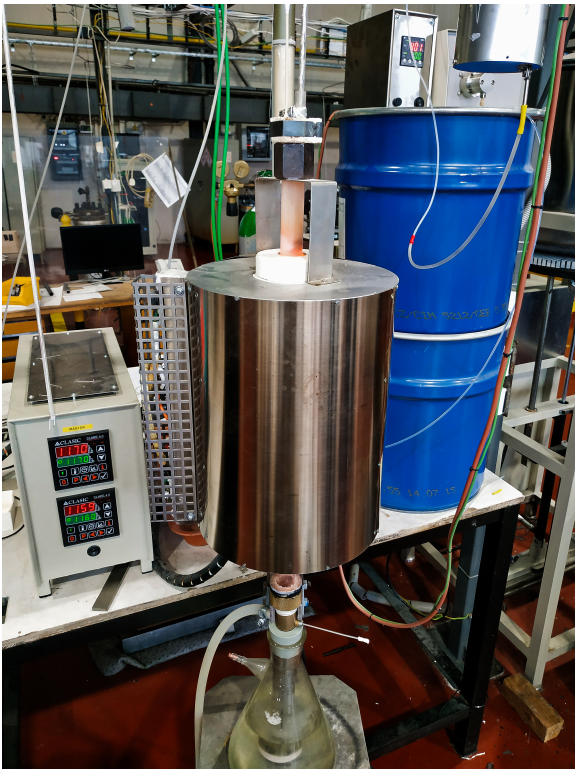
Figure 4. The apparatus for high-temperature oxi- dation.